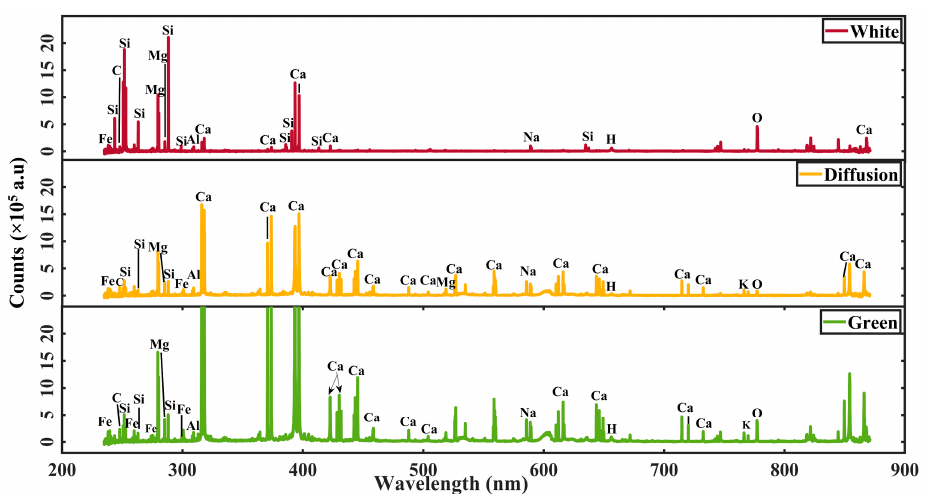
Figure 2. LIBS spectra of white, pale green (diffusion), and green regions of the sample in the wavelength range of 230–850 nm. Table 2. Wavelength of persistence lines of atomic and ionic emission of elements found in the